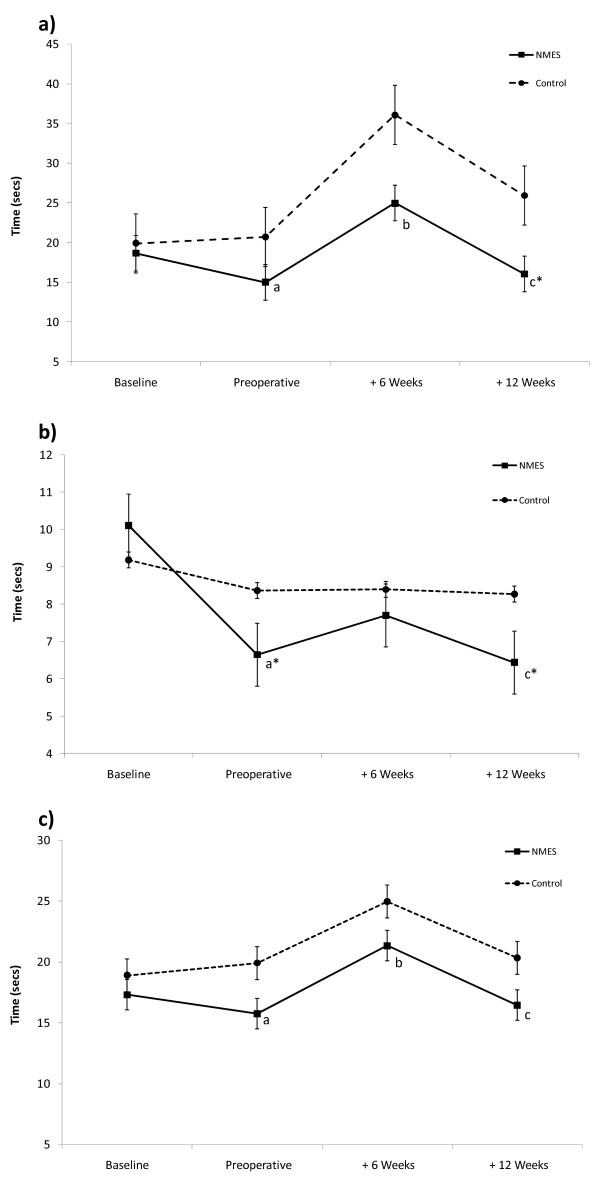
Objective Functional Capacity. ap < 0.05 vs. Baseline; bp < 0.05 vs. Preoperative; cp < 0.05 vs. + 6 Weeks; *p < 0.05 vs. Control; Error Bars represent Standard Error a) Timed Stair-Climb Test. b) Timed Chair-Rise Test. c) 25 metre Timed Walk Test.